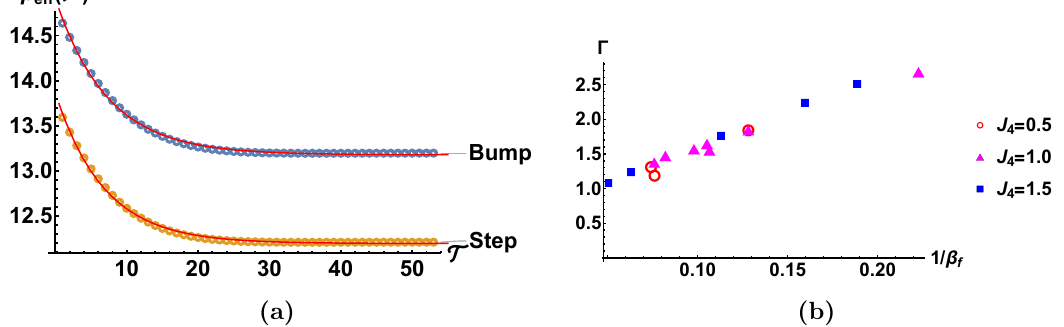
Figure 11. (a) Examples of exponential fit of β eff ( thermalization rate Γ as a function of final temperature 1 /β as well as bump quench